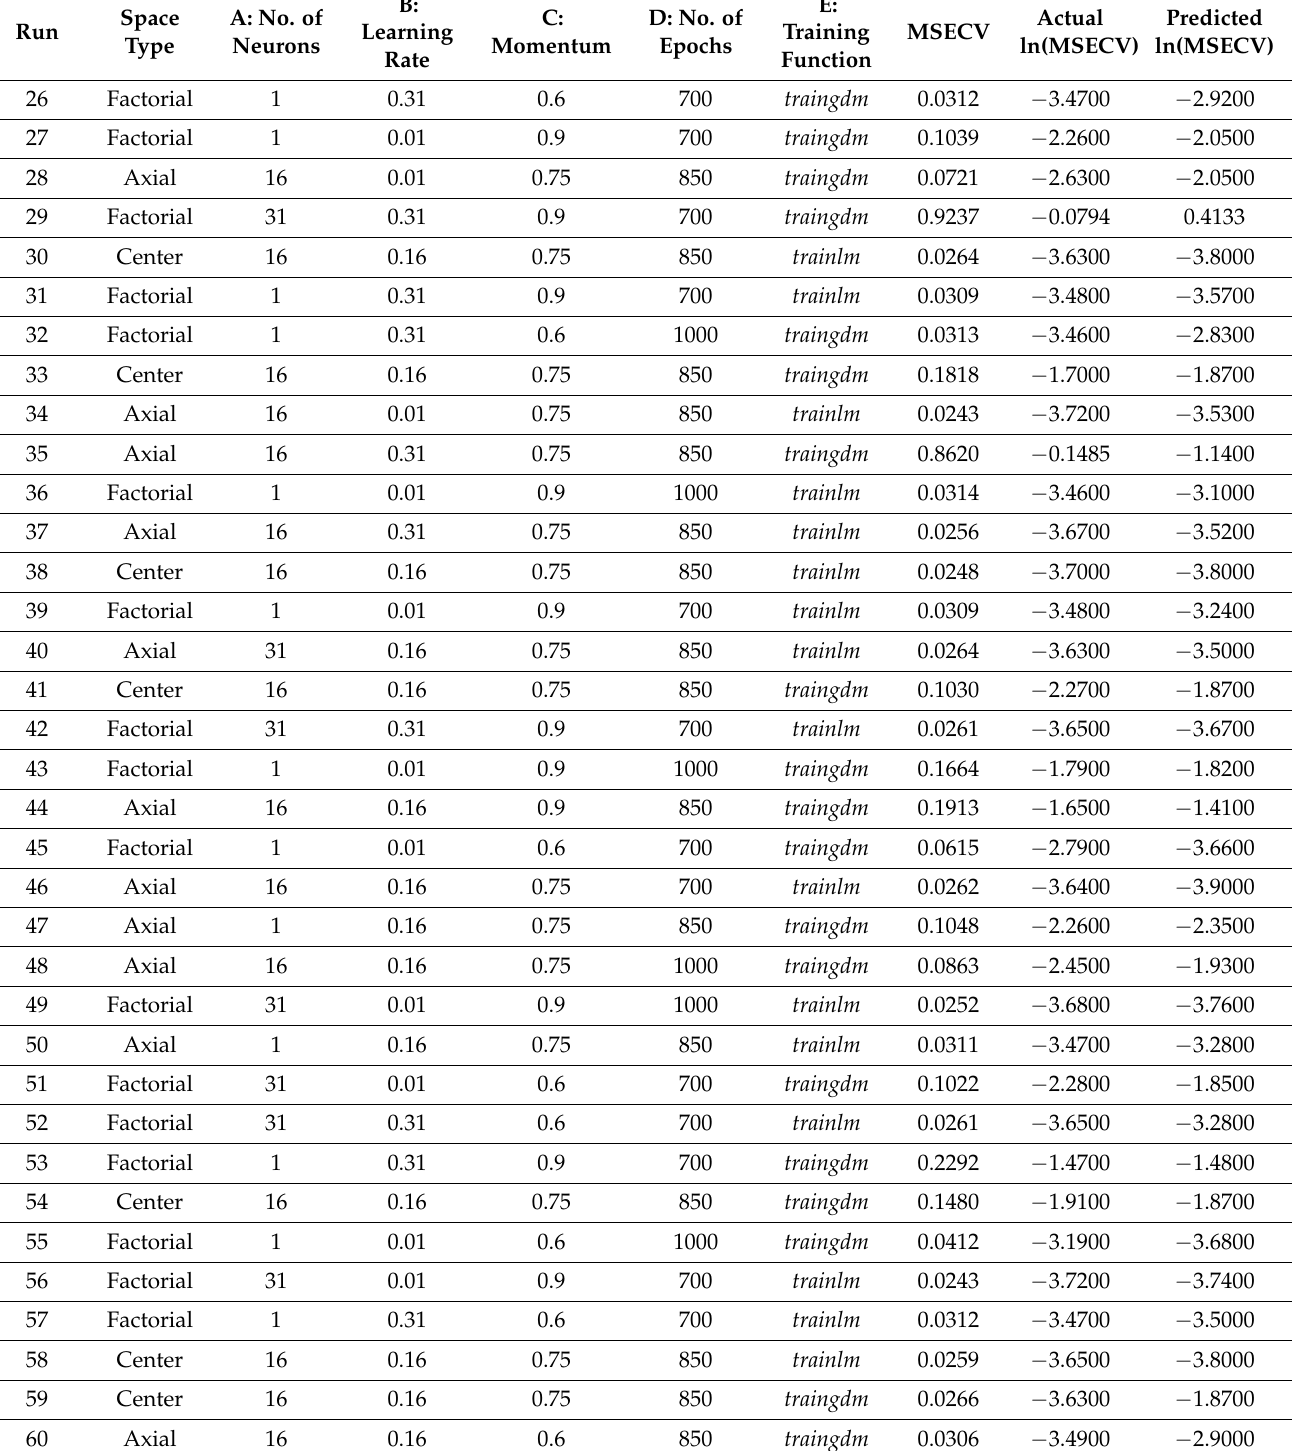
Figure 10a,b show the perturbation plots for the lm and gdm training functions, respectively. The perturbation graph is required to see how the response changes to the changes of its factor from the reference point, with other factors held at constant reference values. In this case, the reference points default at the middle of the design space (the